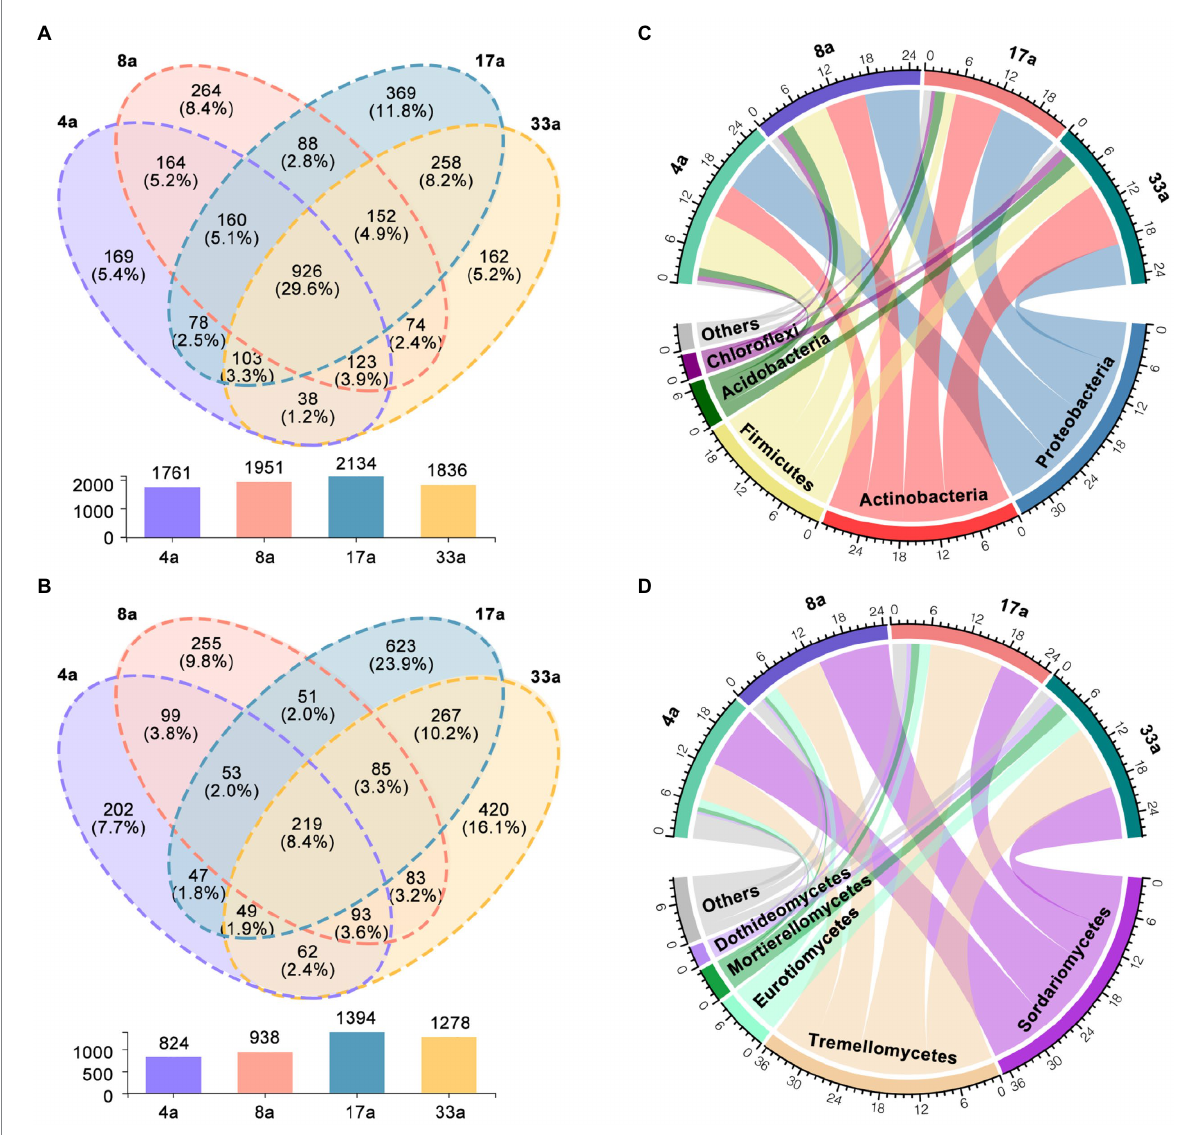
FIGURE 3 Core taxa in the blueberry rhizosphere microbiome. Venn diagram showing specific and shared operational taxonomic units (OTUs) of the rhizosphere bacterial (A) and fungal (B) communities of blueberry at different ages. The shared OTUs were defined as the OTUs that appeared in all samples of each group. (A) Circos plot showing the taxonomical relative abundance of the core bacterial microbiome at the phylum level (C) and fungal taxa at the class level (D) . The thickness of each ribbon represents the relative abundance of bacterial and fungal assigned to different